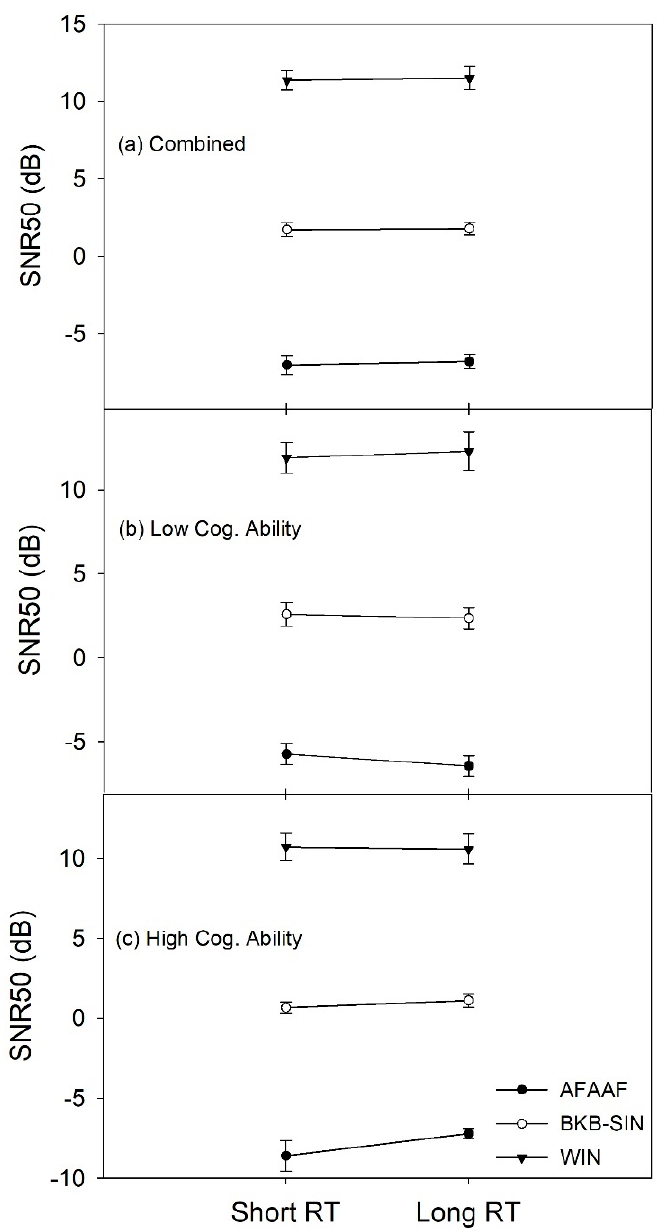
Figure 9. Relationship between RT and speech recognition performance with each test for ( a ) the two cognitive performance groups were combined, ( b ) the low cognitive performance group, and ( c ) the high cognitive performance group. Error bars represent standard errors.